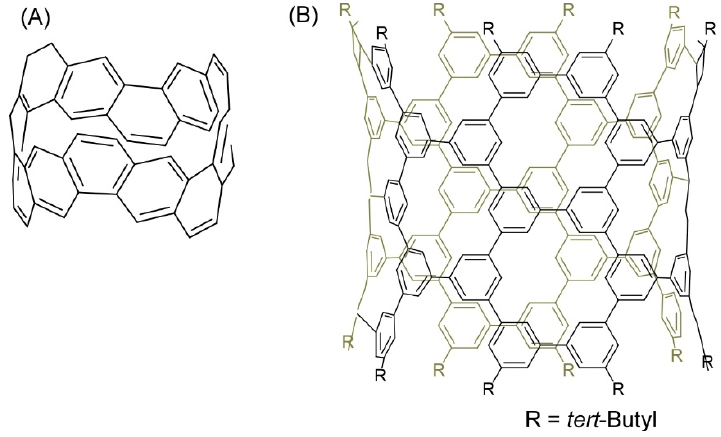
Figure 6. ( A ) Carbon nanobelt with a closed loop of fully fused edge-sharing benzene rings; ( B ) Cylindrical C 304 H 264 molecule with 40 benzene (phenine) units bonded mutually at the 1, 3, and 5 positions.